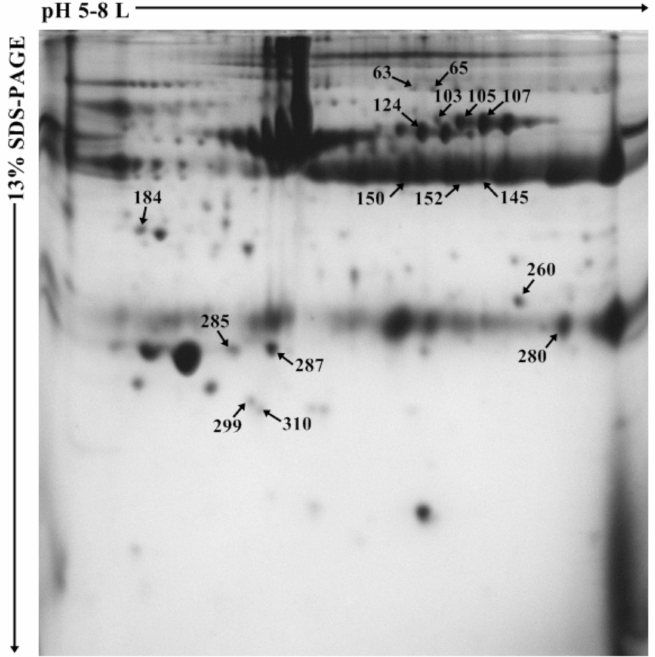
Figure 1. Representative 2D–PAGE image of bovine plasma. Spots with statistically significant intensity difference ( p < 0.05) between low– and high–PACAP (pituitary adenylate cyclase-activating polypeptide) -concentration groups are marked with numbers.